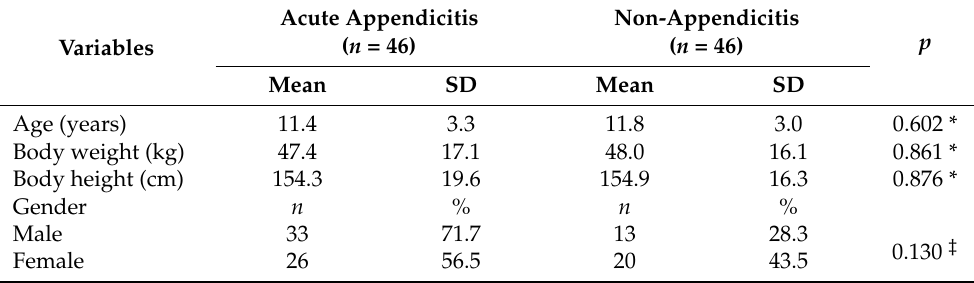
Table 1. Demographic data of the